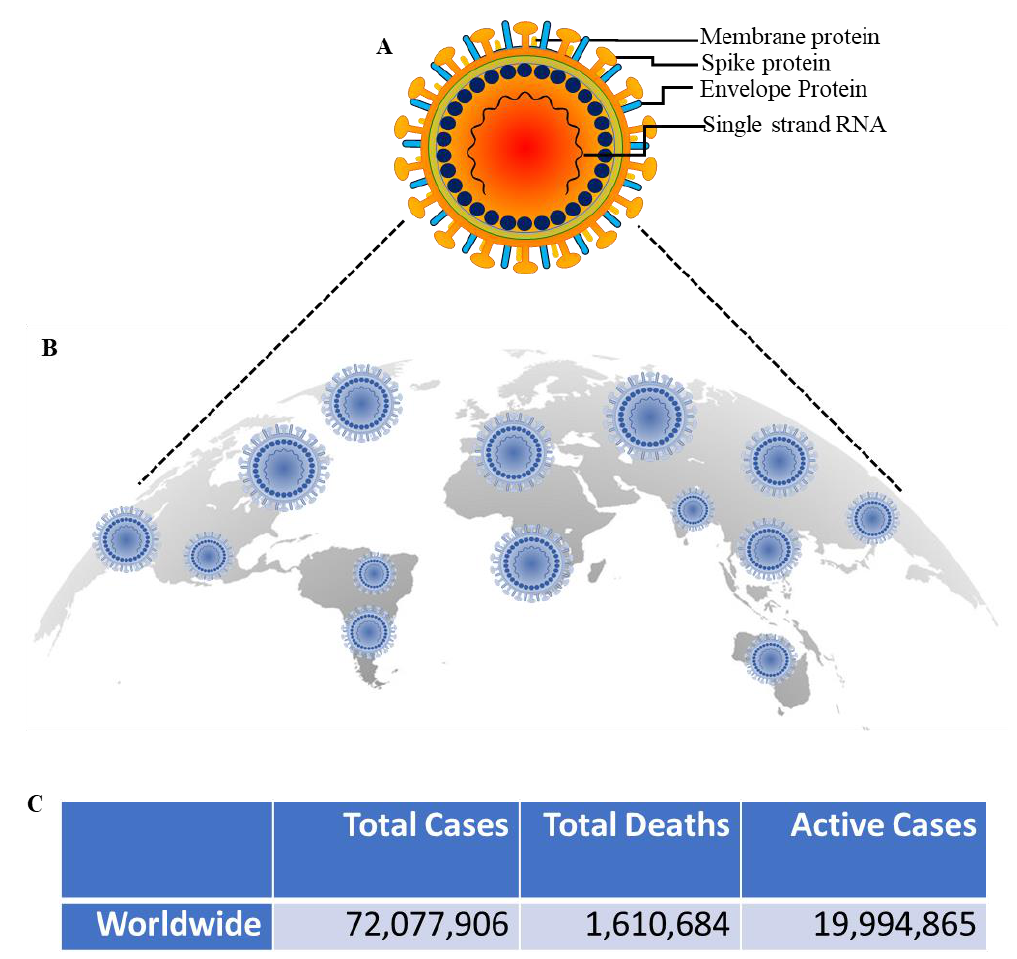
Figure 1. Global COVID-19 pandemic. ( A ); SARS-CoV-2 structure ( B ); Schematic representation of putative worldwide distribution of total cases, total deaths, and the active cases of COVID-19. ( C ); The number of total COVID-19 cases and deaths associated to COVID-19 was derived from Worldometer. Information obtained from https://www.worldometers.info/coronavirus/ on 12 December